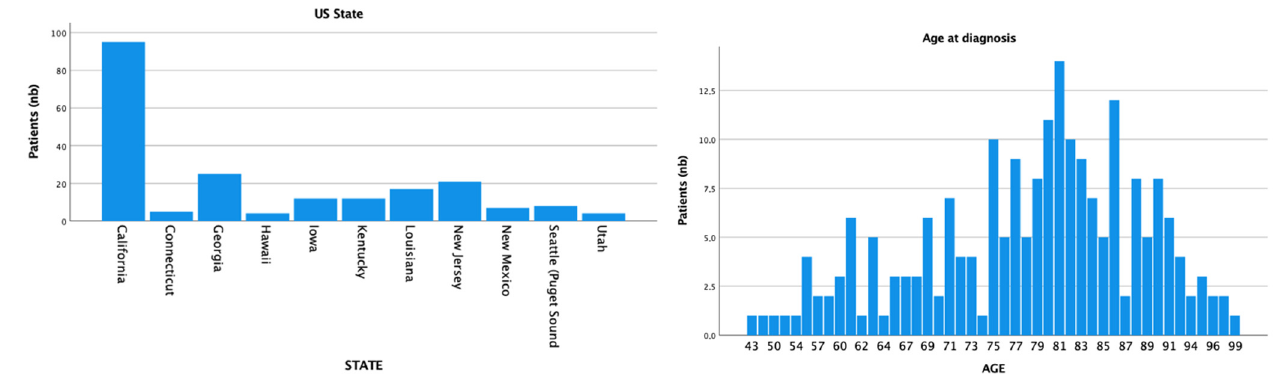
Figure 1. Registry location and age at diagnosis distribution.